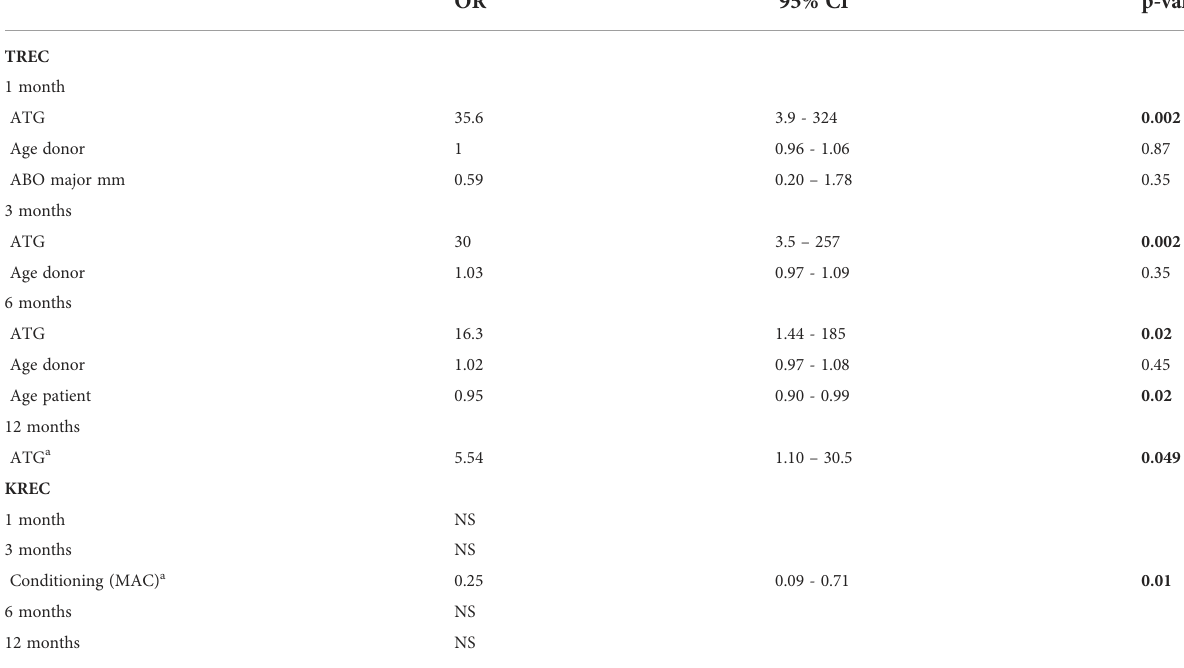
TABLE 2 Patients with ATG in their conditioning regimen had lower TREC values post-HSCT. OR 95% CI p-value